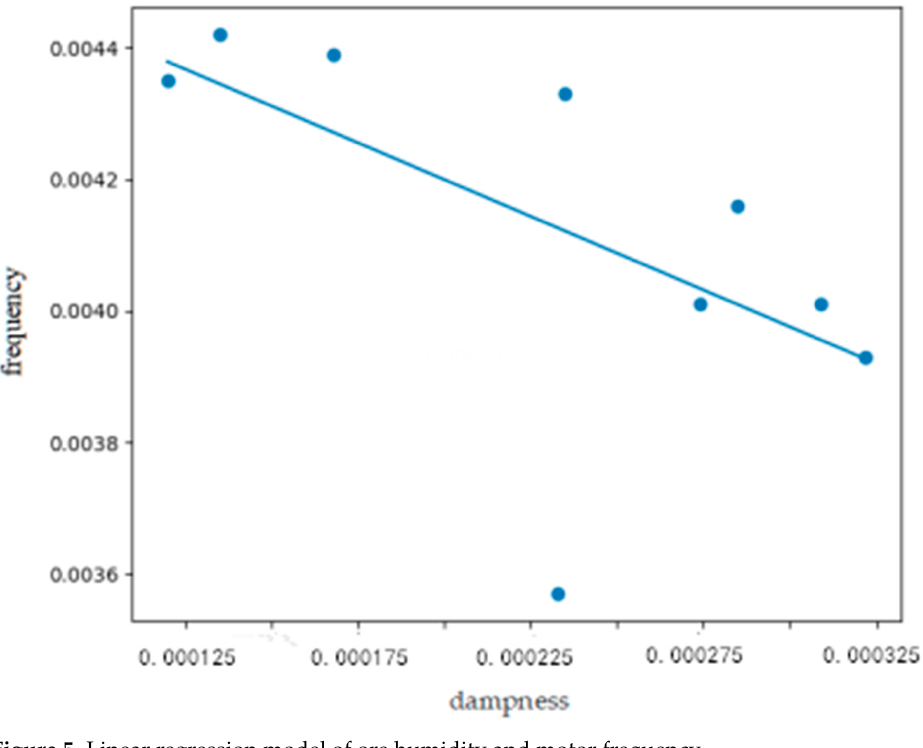
Figure 5. Linear regression model of ore humidity and motor frequency.